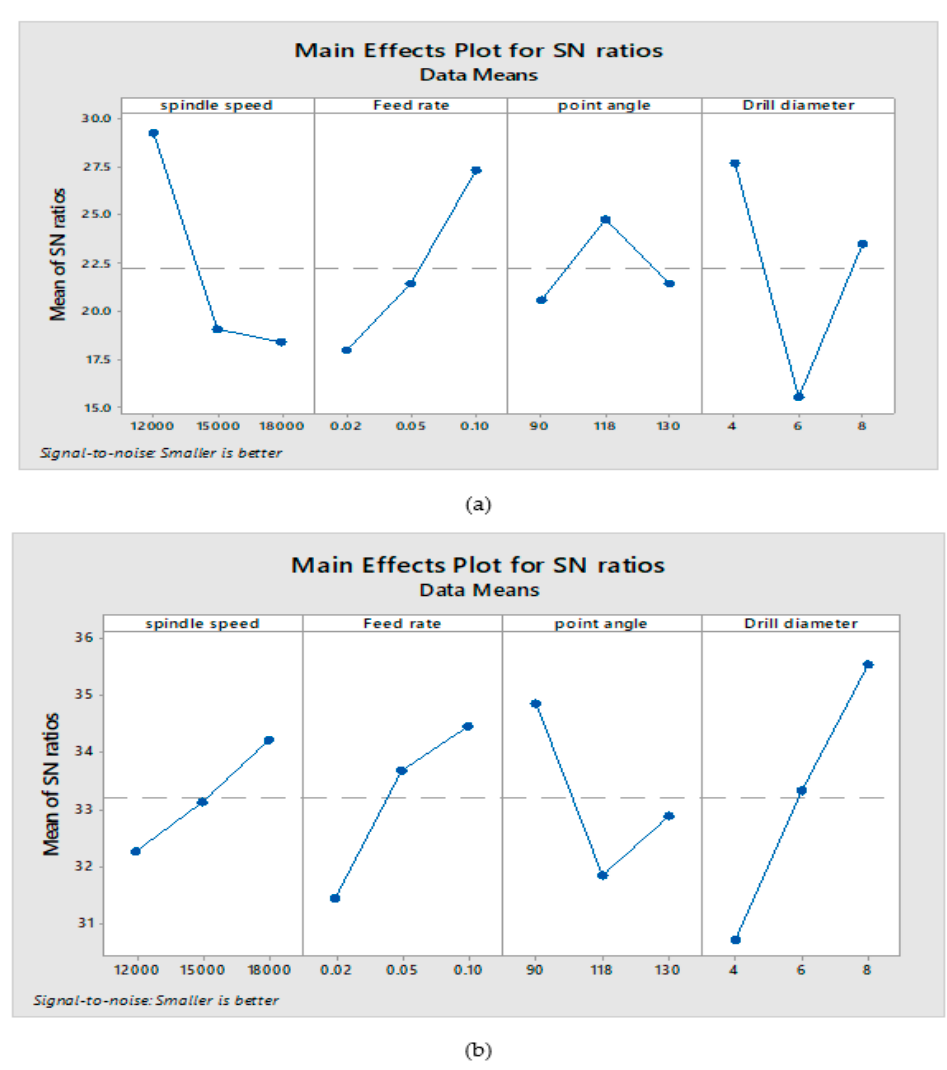
Figure 4. Main effects plots for S/N ratios of ( a ) Hole size errors and ( b ) Circularity errors.